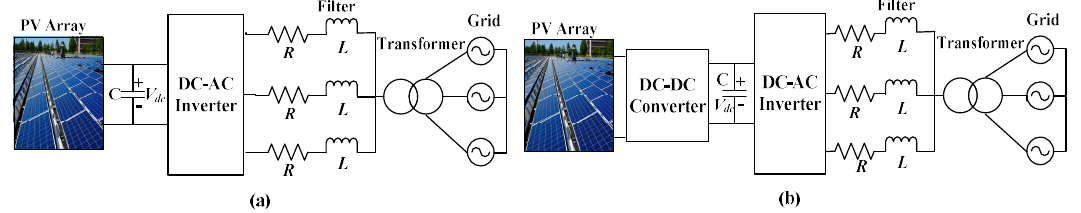
Figure 2. PV configuration systems: ( a ) single stage and ( b ) two stage [4].